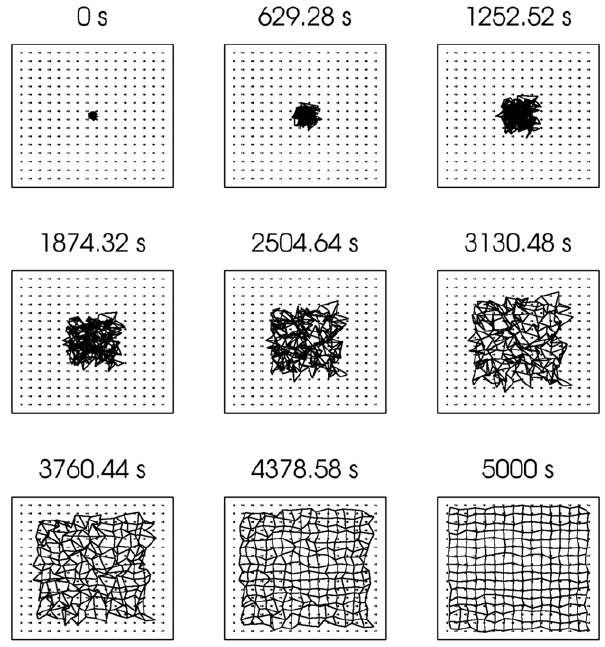
Figure 9. Change in CoM for the model retinogeniculate pathway (from the left retina to layer A1 of the dLGN, both layers develop simultaneously but all results are shown in one pathway for convenience). Using the method of visualizing retinogeniculate weights from [34], the CoM of the weights projecting to a given dLGN cell (see (23)) is depicted as a node connected to its 4 nearest neighbors in solid black (2 for cells at the edge, since the boundaries are non-periodic). The ideal topography is visualized by the dotted grid defined by the points in a ijpq , where p ~ i and q ~ j (site of initial retinotopic bias). Over the course of the simulation, the CoMs approach the ideal (the time during the simulation at which the CoMs were assessed is shown just above each